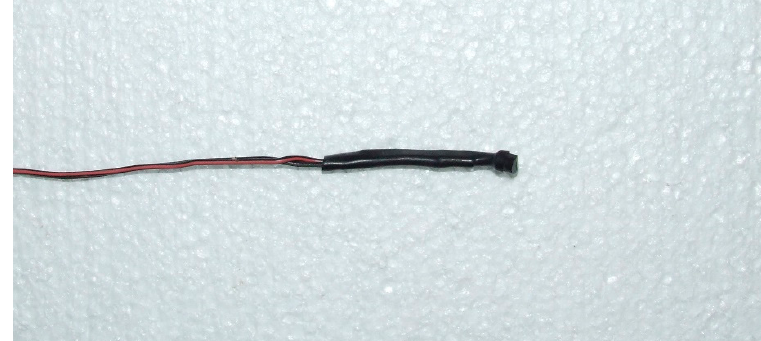
Figure 9. Temperature measurement sensor.